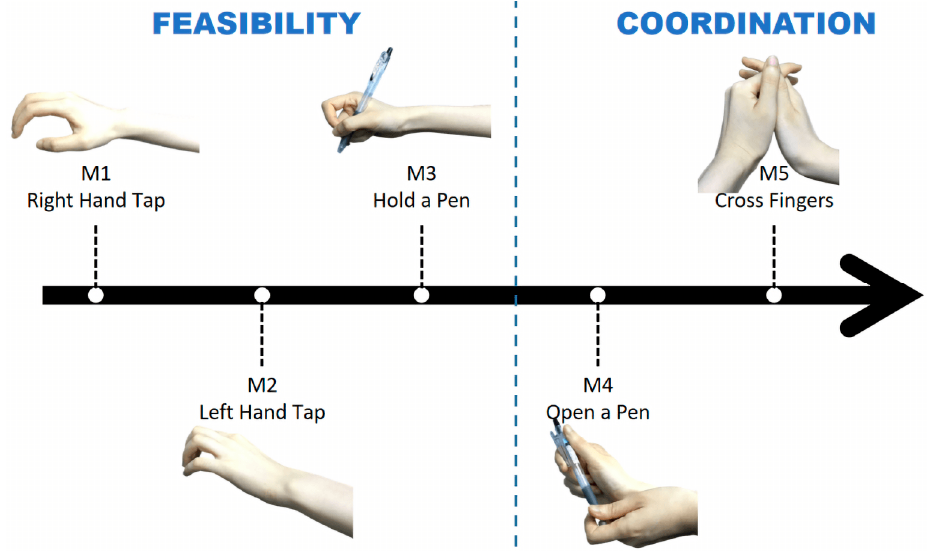
Figure 1. Tasks in the experiment. M1–M3 were to examine the feasibility, and M4–M5 were set for coordination. M1: move specific right fingers according to the auditory code; M2: move specific left fingers according to the auditory code; M3: make the gesture of holding a pen and ready to write; M4: unscrew the pen; M5: fingers of both hands cross over each other.